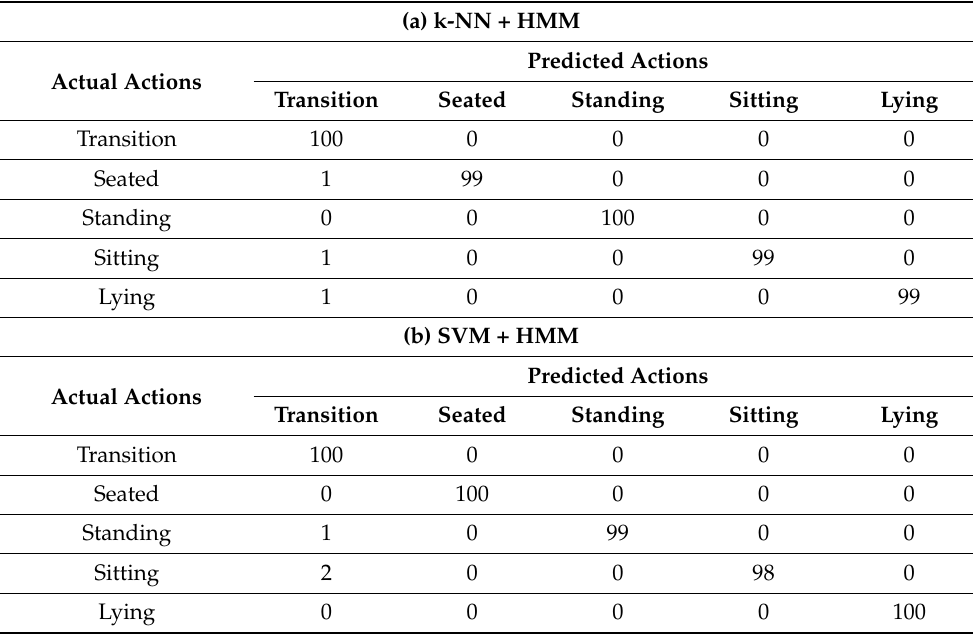
Table 4. Confusion matrices of HMM prediction results tested on the training